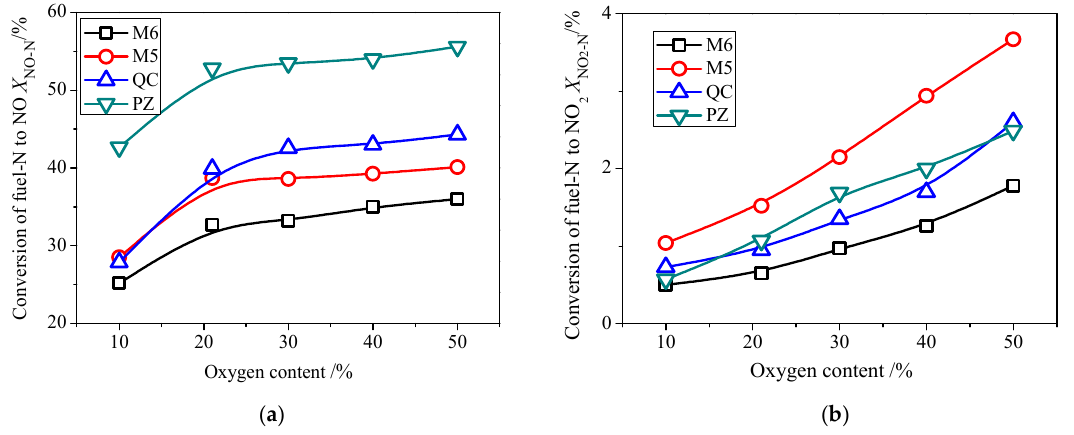
Figure 6. The comparison between NO and NO 2 emissions with oxygen content at 1200 °C under the oxy-fuel condition. ( a ) Conversion to NO; ( b ) Conversion to NO 2 .